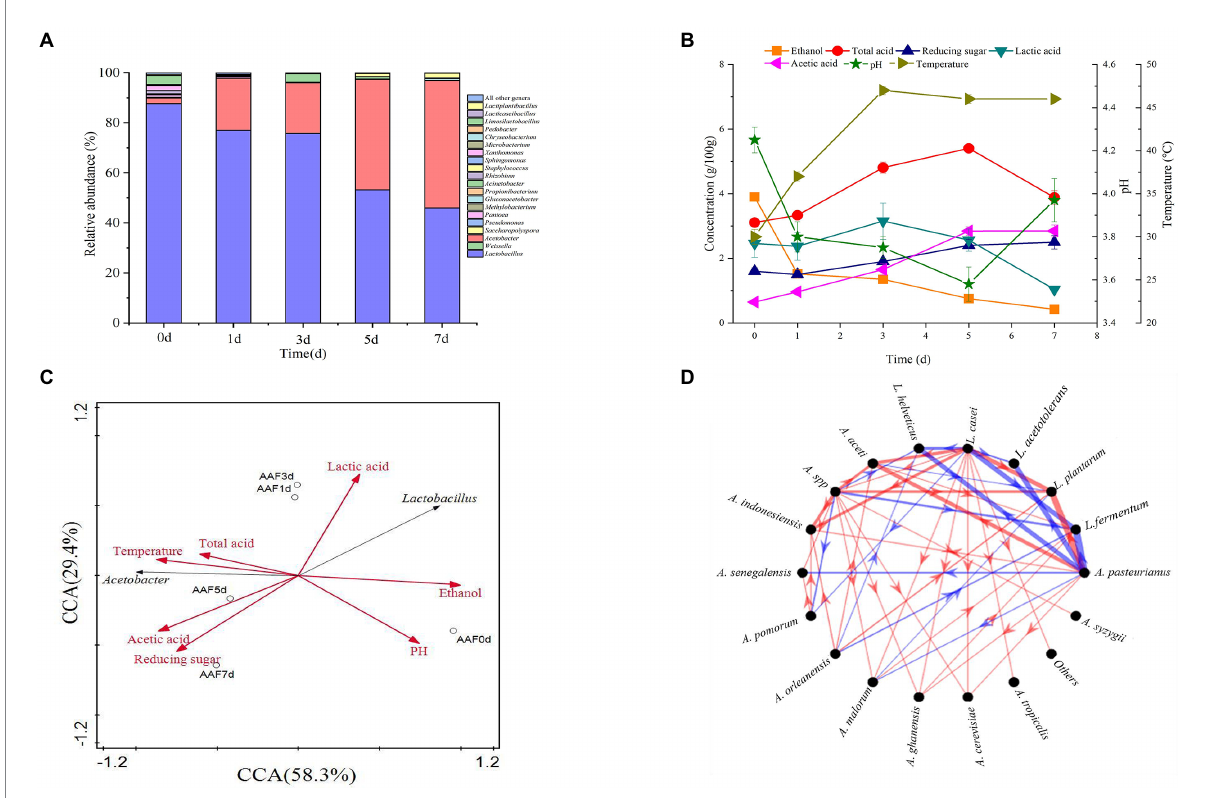
FIGURE 1 Time curves and the microbial correlations in SAV fermentation. (A) The composition of bacterial communities; (B) The physicochemical indicators; (C) CCA analysis; (D) Interaction networks of Lactobacillus and Acetobacter : Edge thickness represents the correlation value, and edge color represents the positive (red) or negative (blue)